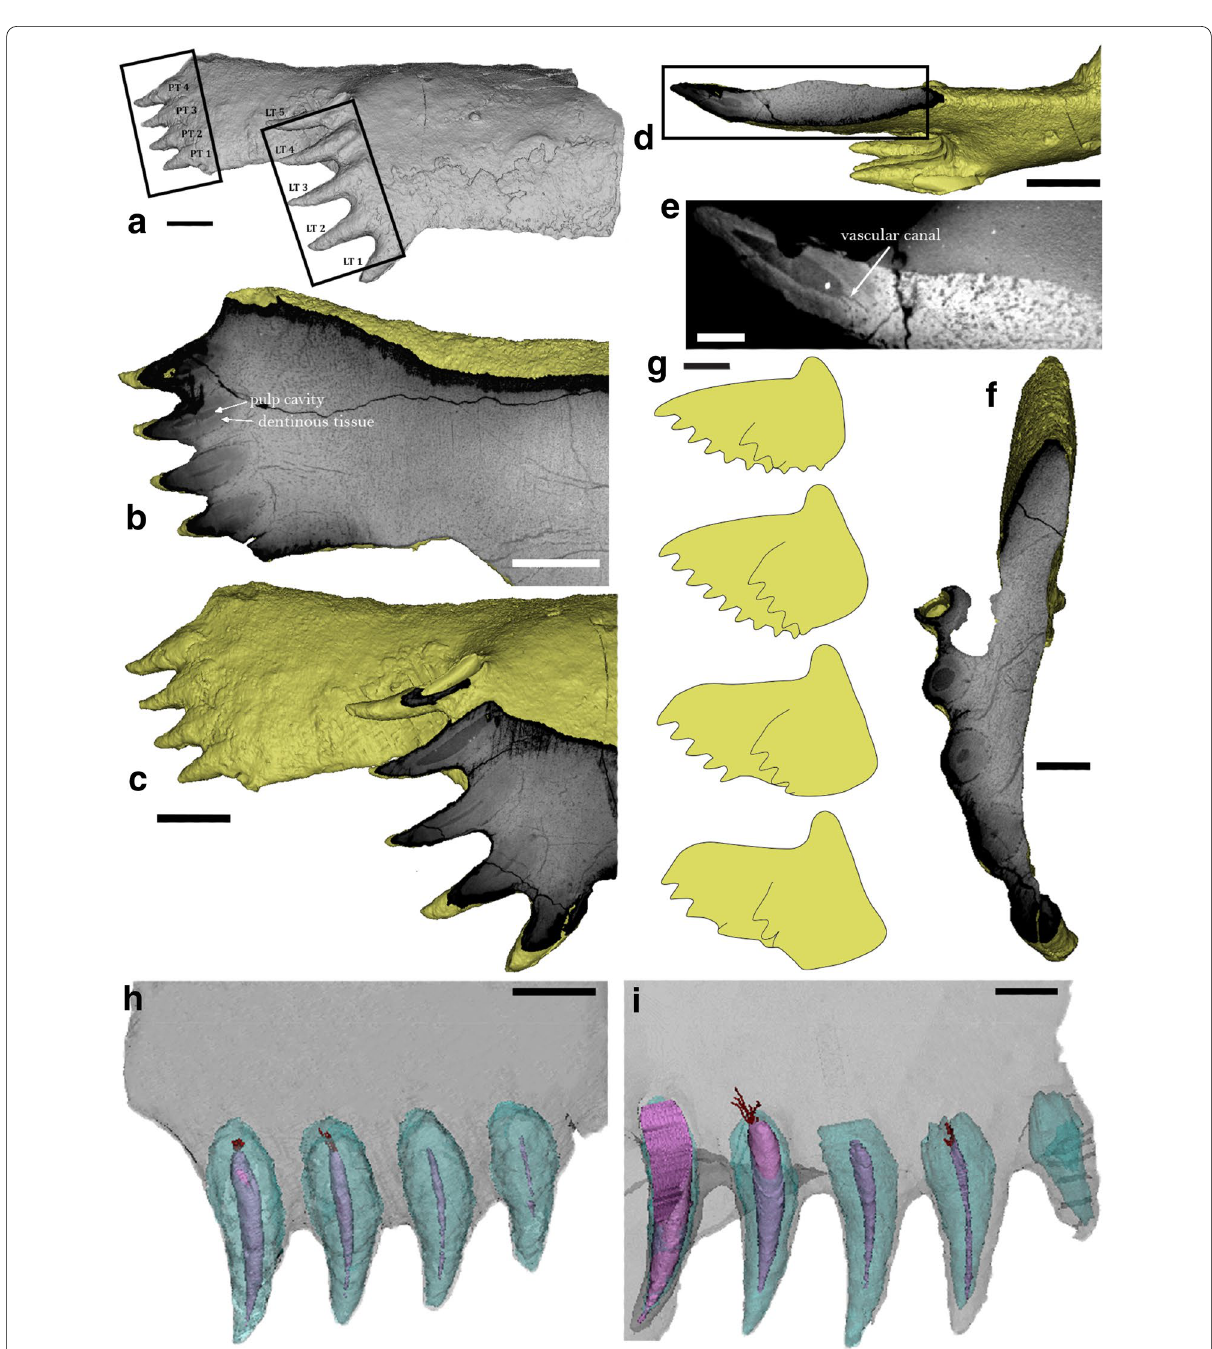
Fig. 4 CT slices of the posterior superognathal of Leptodontichthys ziregensis gen. et sp. nov. (PIMUZ A/I 5022). a Overview in labial view. b – f , both tooth rows showing layers of dentin and the pulp cavities. b Parasagittal view of the posterior row and c of the lateral row. d , e , transverse sections ( e : close-up). f Frontal section. g Growth development of Plourdosteus canadensis according to Ørvig (1980). h Posterior row and i lateral row. Both tooth rows of L. ziregensis gen. et sp. nov. were 3D reconstructed to show these layers and some preserved basal canals. Scale bars represent 10 mm ( a – d , g ), 2 mm ( e ), 4 mm ( f ) and 5 mm ( h , i ). LT, Lateral Tooth; PT, Posterior